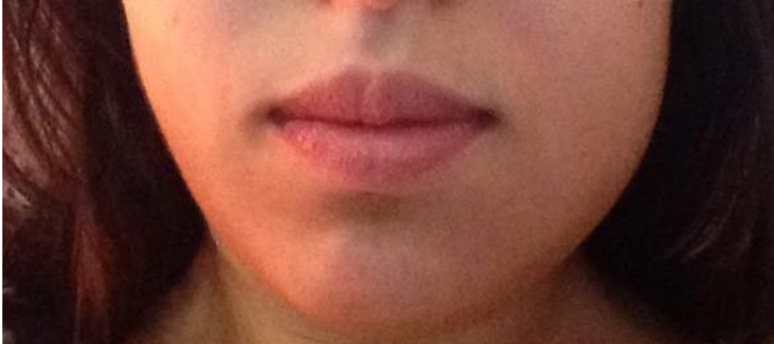
Figure 4. In this image, the postoperative swelling is visible on the left side of the face of the patient after 3.8 teeth extraction.